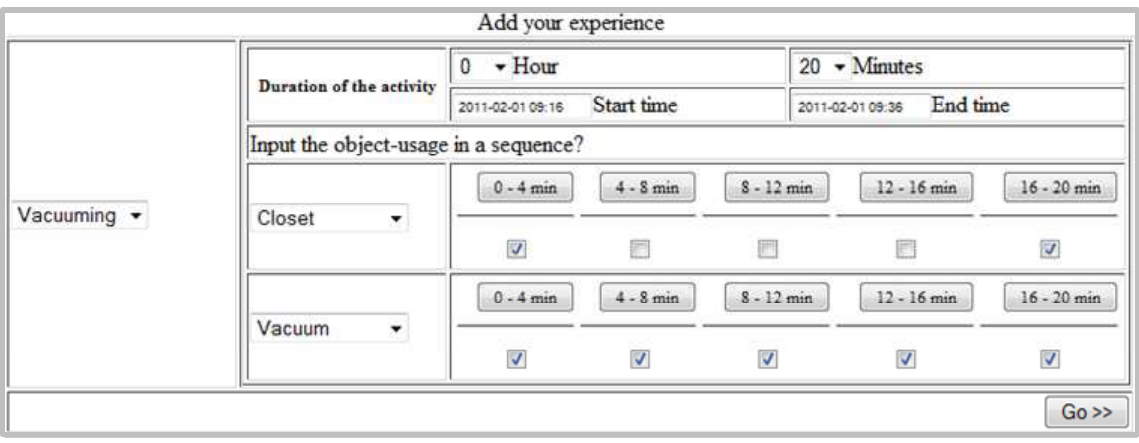
Figure 8. Inputting activity information using EST.